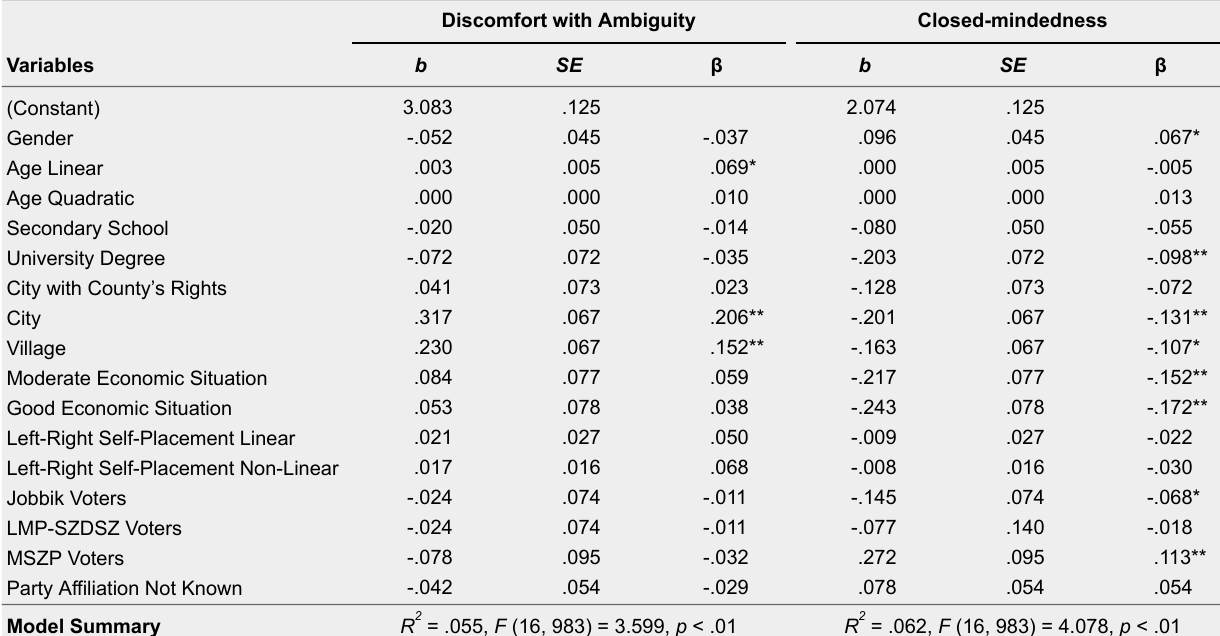
Multiple Regression Analyses After the Second Set of Predictors (Political Predictors) Were Added to the Model. Dependent Variables: Discomfort with Ambiguity and Closed-mindedness (N = 1000) Closed-mindednessDiscomfort with